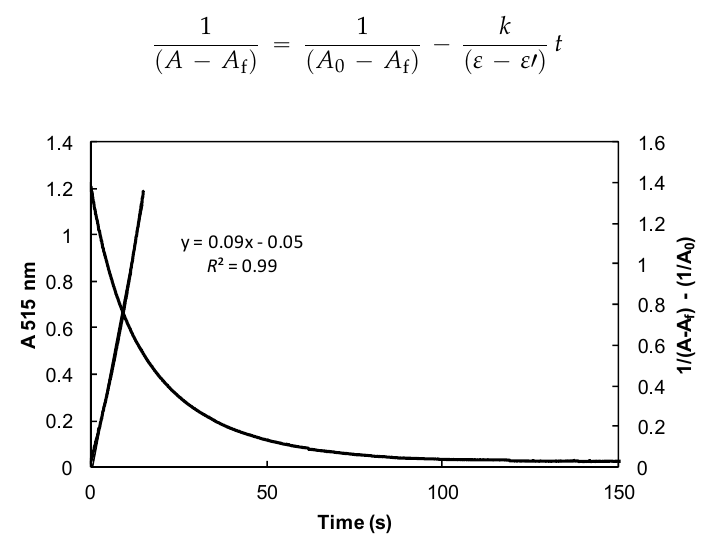
Figure 2. Evolution of the absorbance of DPPH • radical at 515 nm (1.25 × 10 − 4 mol·L − 1 ) in the presence of hydroxytyrosol 62 (1.25 × 10 − 4 mol·L − 1 ) in toluene at 20 °C. Linearization curve according to second order kinetics (SOK) (Equation (8)). Int. J. Mol. Sci. 2016 , 17 , 1220 10 of 26